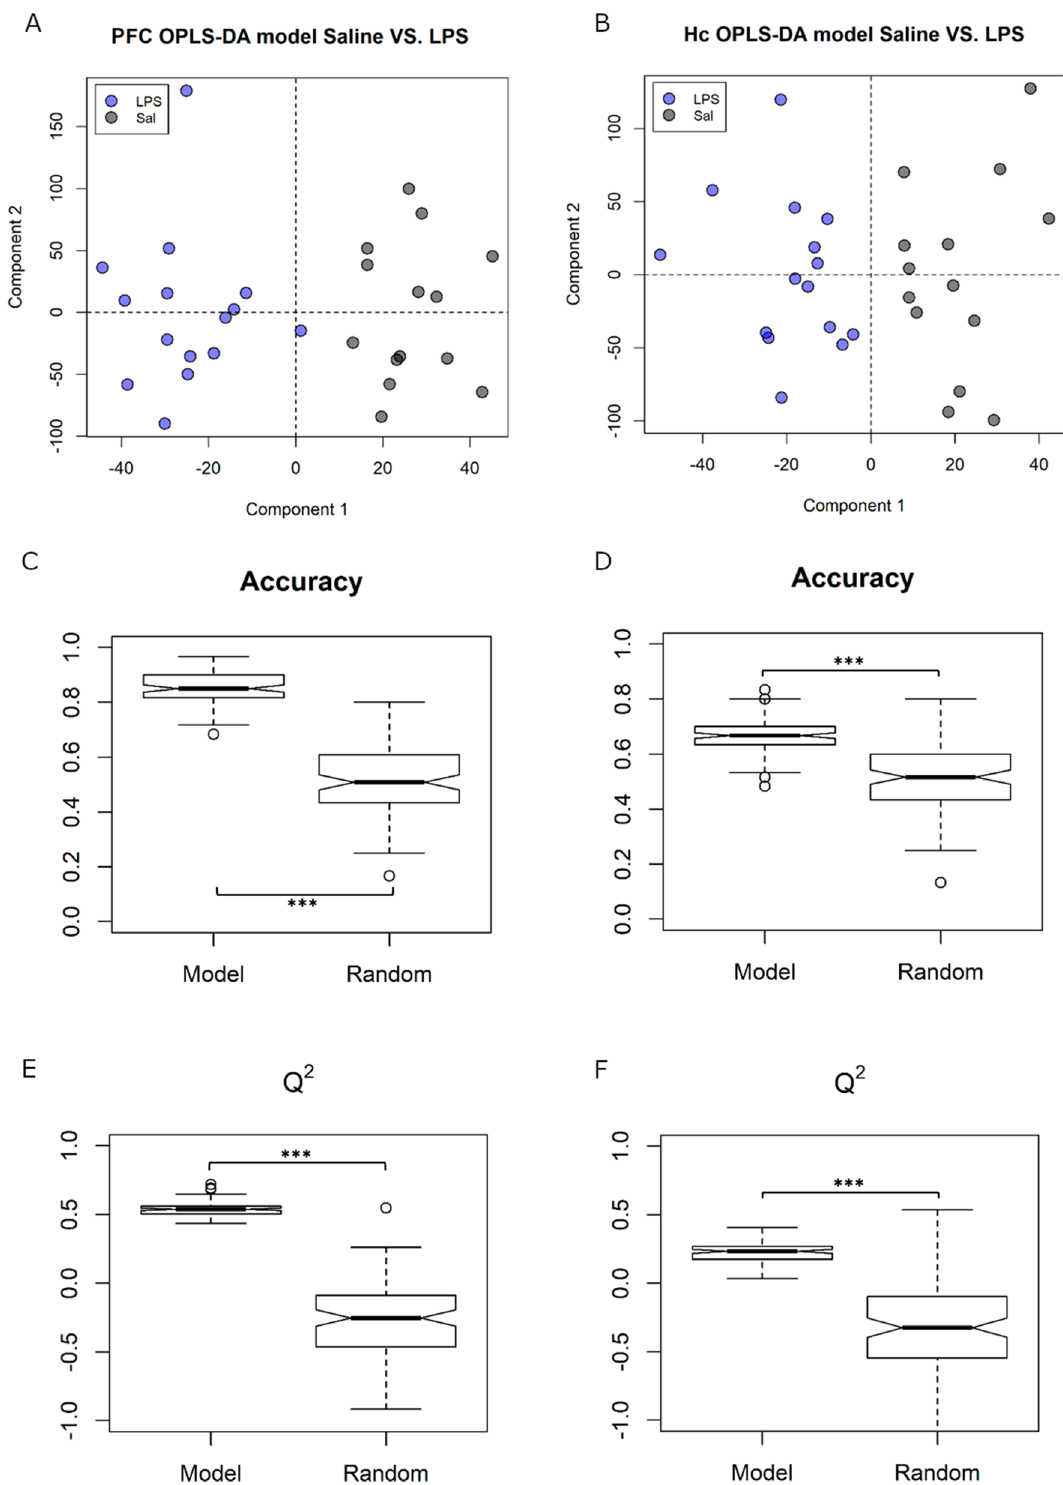
Figure 6. Brain Saline/LPS models showed ( A and B ) good discrimination between treatment groups when treatment was set as class (OPLS-DA) in both PFC and Hc. ( C and D ) Predictive accuracy and ( E and F ) Q 2 measures were both significantly higher in the ensemble of Saline/LPS models compared to the null models with group labels randomly permuted. *** p <